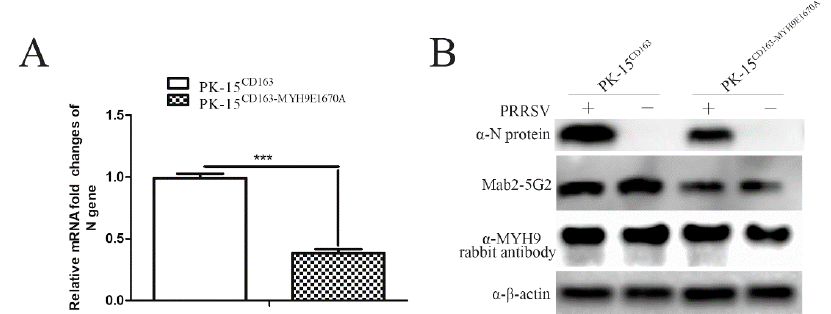
Figure 7. E1670A mutation of MYH9 in permissive cells confer partial resistance to PRRSV infection. ( A ) PRRSV permissive PK-15 CD163 cells and PK-15 CD163-MYH9E1670A were infected by PRRSV at 0.1 MOI